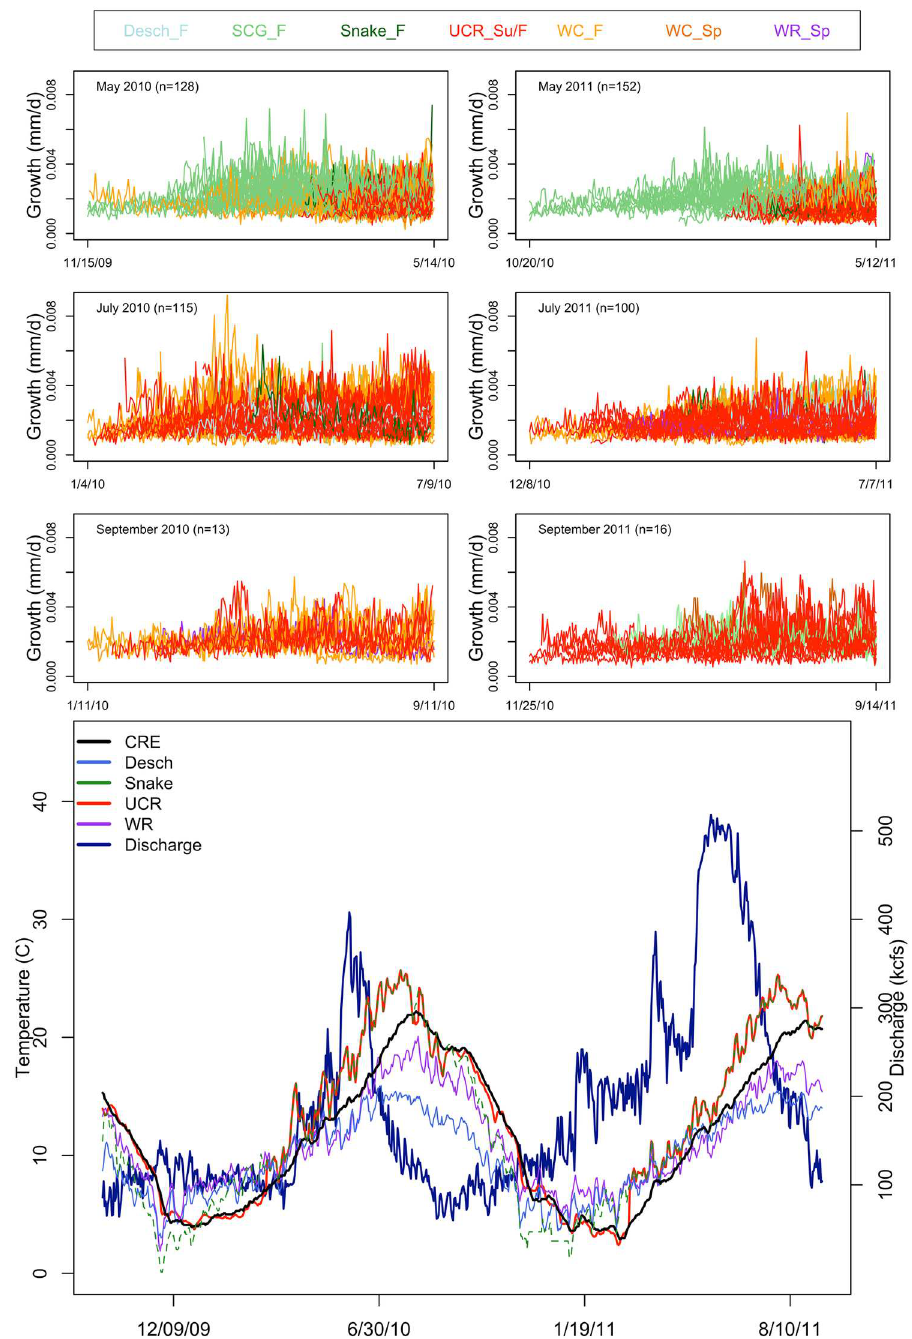
Fig 2. Growth time seriesfor each individualjuvenileChinooksalmonfrom estimatedemergence date to capturein the ColumbiaRiver estuary(topsix panels)and temperature and discharge covariate time series(bottomfigure)used in the d matrix. Each timeserieswas coloredby geneticstock of origin(juvenile Chinookgrowth timeseries)and location(covariate timeseries).The covariate figure includestemperature fromeach majortributaryand the Columbia River estuarytemperature (CRE)and discharge (Discharge).